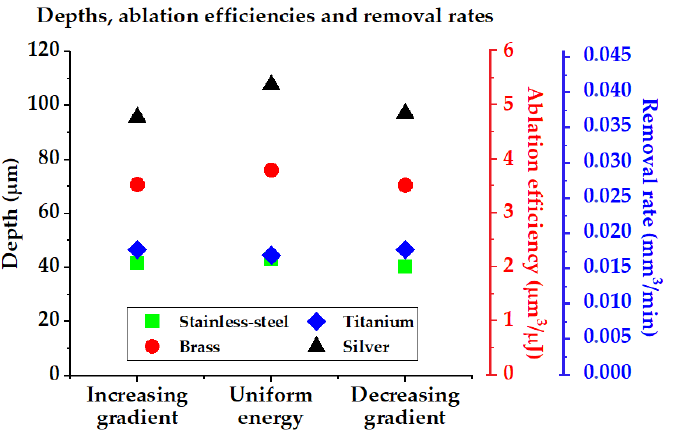
Figure 8. Experimental depths, ablation efficiencies and removal rates of the ablated surfaces on stainless steel, titanium, brass and silver. The use of ascending or descending pulse energy sequence does not significantly affect the ablation performance.